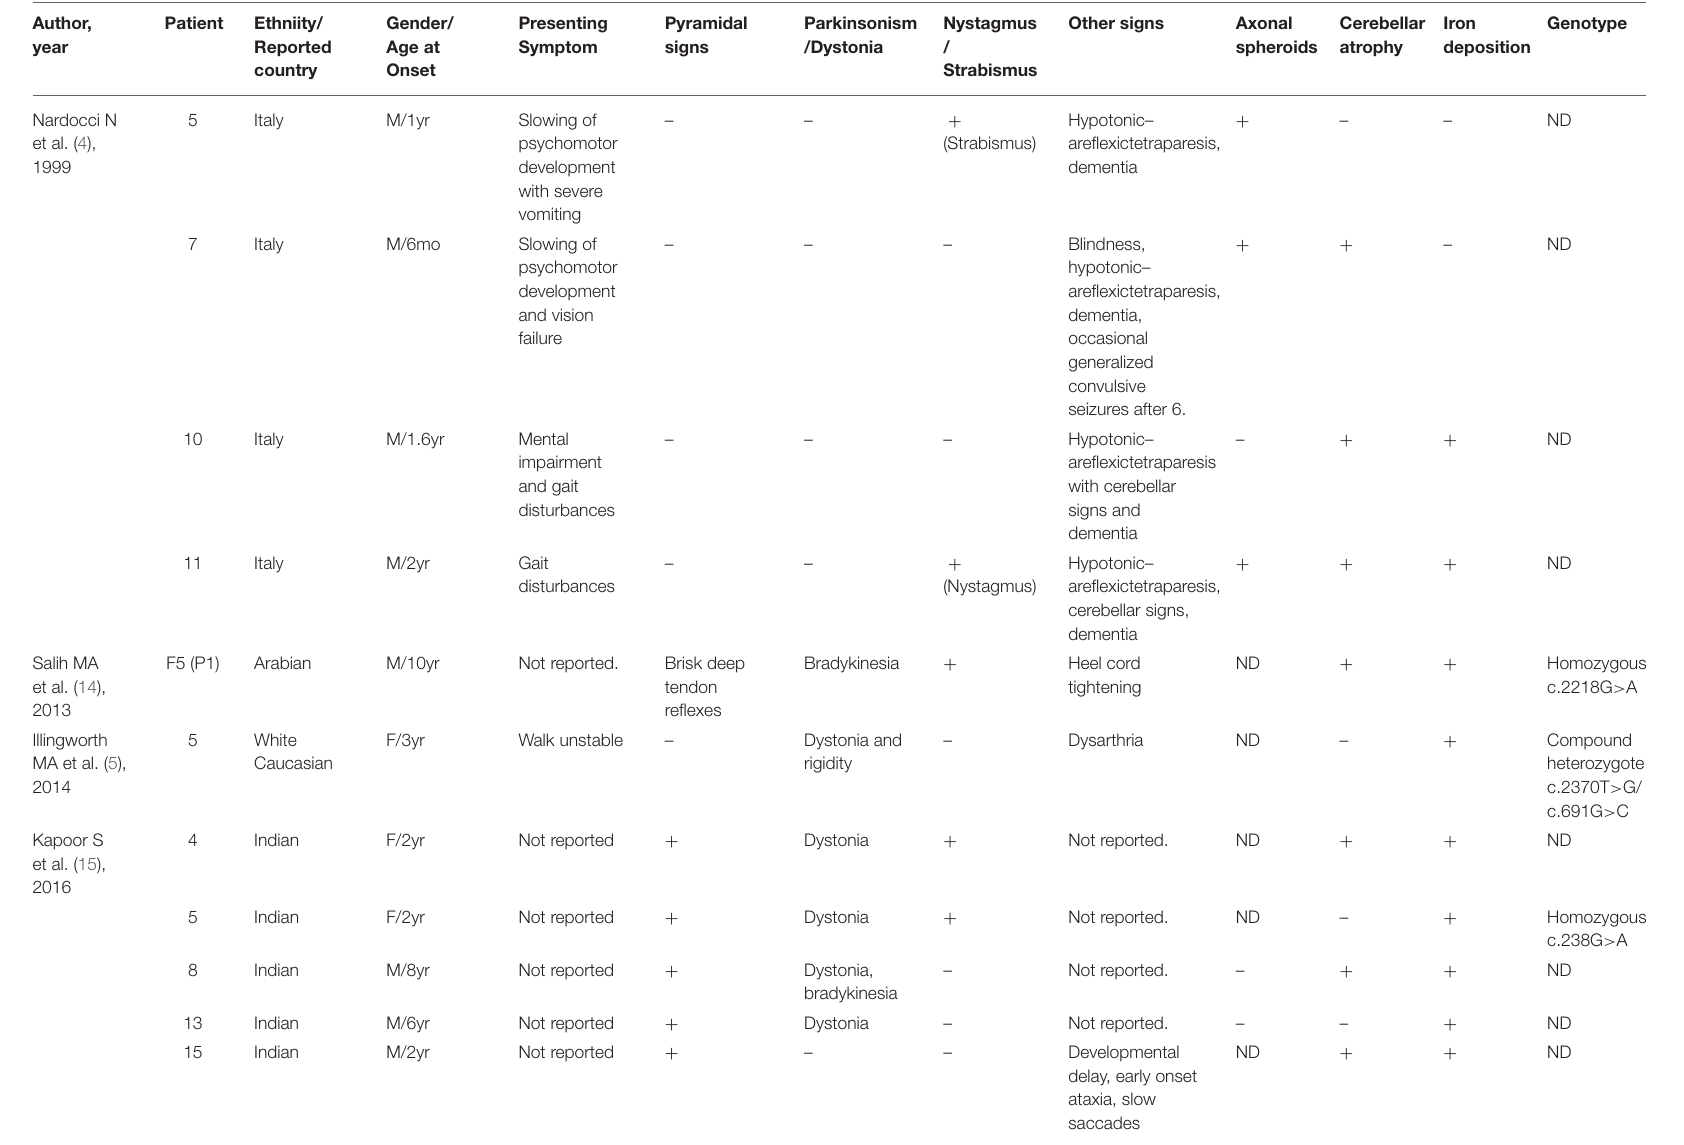
TABLE 2 | Summary of demographic and clinical findings of reported 21 ANAD